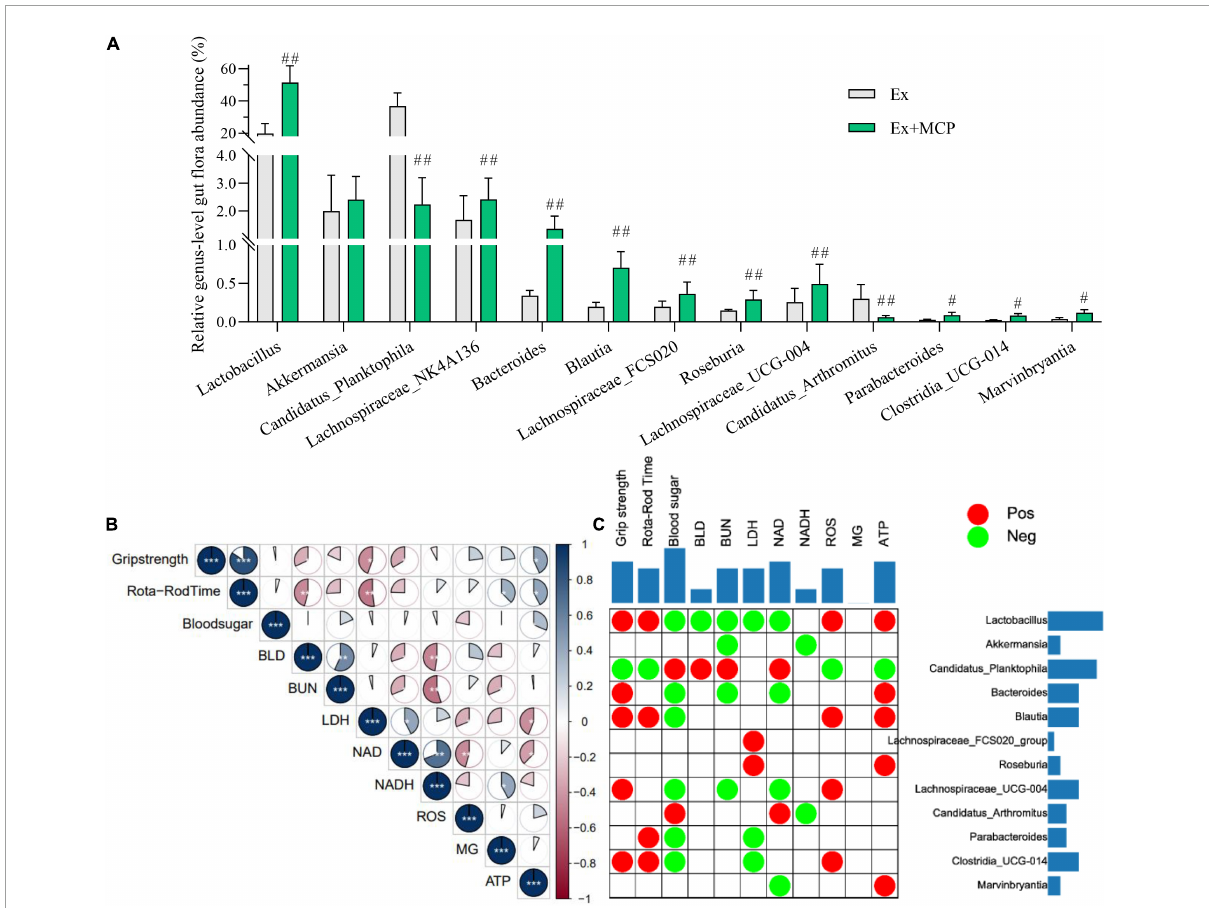
FIGURE4 Mice gut microbiota and their correlation to the fatigue-related biochemical parameters of exercising mice. (A) Relative genus-level gut flora abundance; (B) Pearson correlation analysis among fatigue-related indicators; (C) Pearson correlation analysis between fatigue-related indicators and relative genus-level gut flora abundance (red plots represent r ≥ 0.5, and green represent r ≤ − 0.5; the two-side blue bar represents the number of positive/negative plots in each row or column, reflecting the importance of the gut microbiota (row) or biochemical parameter (column) in the correlation grid). # p < 0.05, ## p < 0.01 vs exercise (Ex)